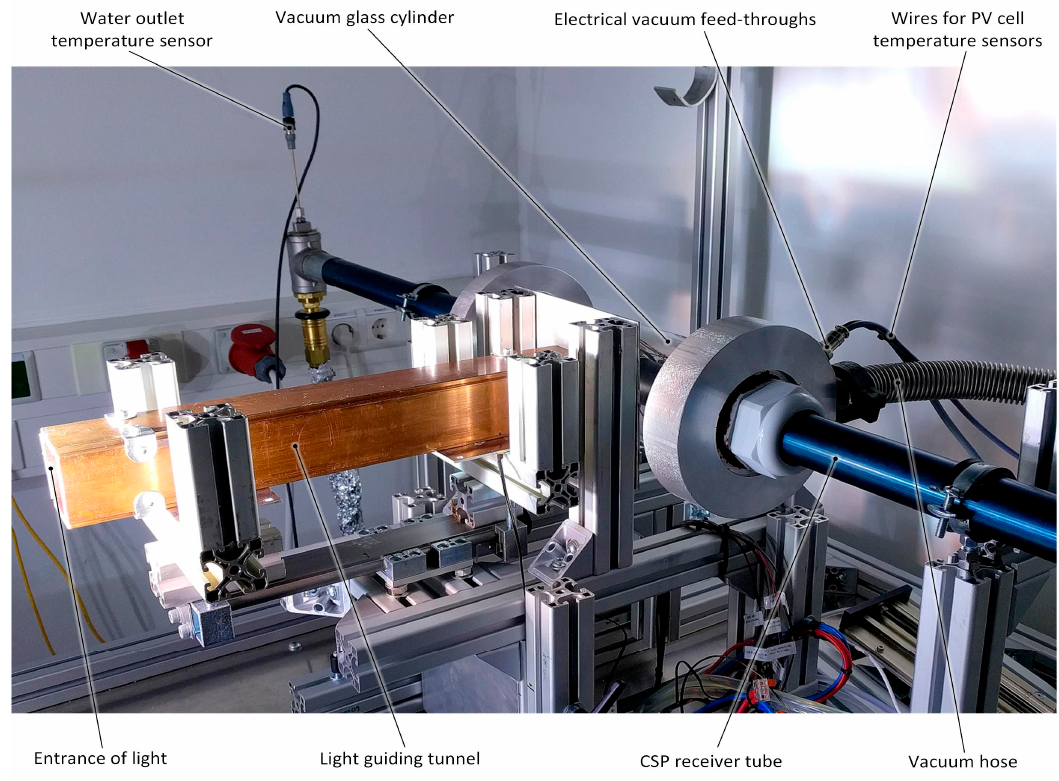
Figure 13. Solar simulator tests with the retrofitted absorber tube.